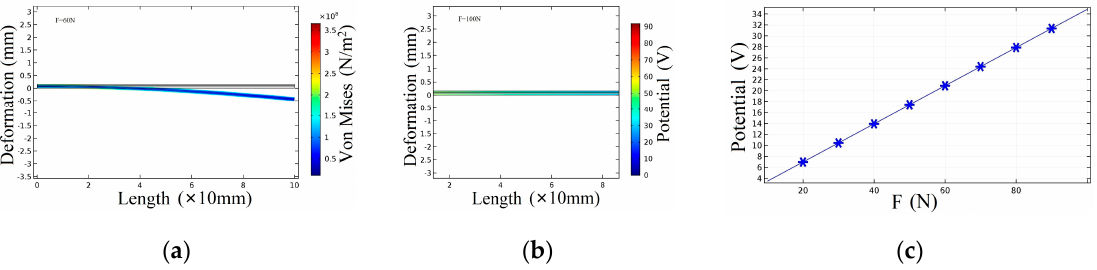
Figure 8. Piezoelectric transducer stress and electric potential and their relationship curve. ( a ) deformation under stress; ( b ) potential distribution; and ( c ) relationship between stress and electric potential.